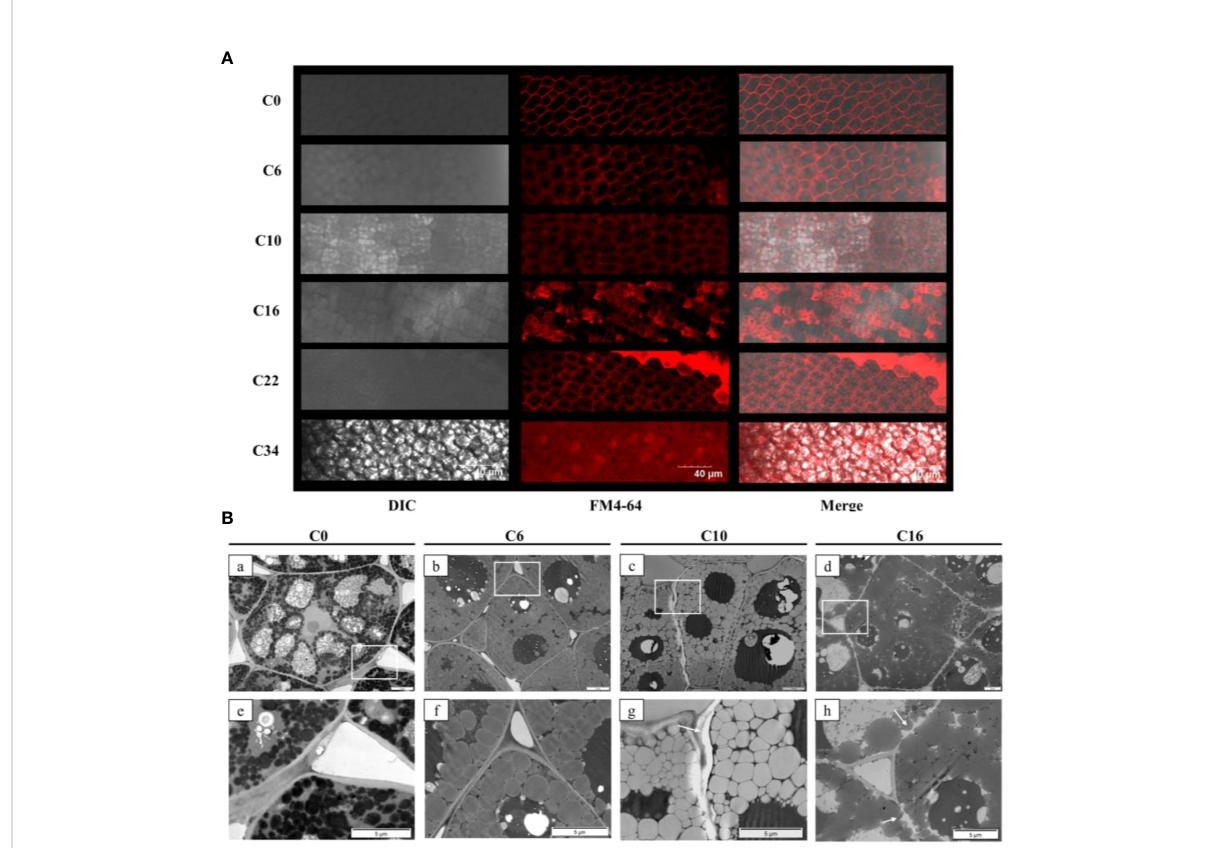
FIGURE 5 Effects of aging on the integrity of the plasma membrane of saf fl ower seeds. (A) Changes in cell membrane permeability of saf fl ower seeds with increasing aging days. Bars = 40 m m. (B) Ultrastructure of cotyledon tissues and cell wall complex from C0 [ (a, e) ], C6 [ (b, f) ], C10 [ (c, g) ], and C16 [ (d, h) ]. The white box in the fi rst column diagram represents the enlarged position of the second column in the fi rst column. White arrows indicate the location of cell damage. Bars = 5 m